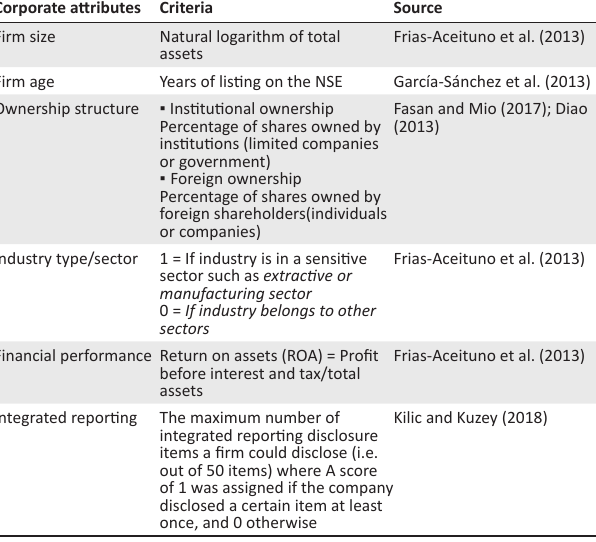
TABLE 2: Measurement of variables.